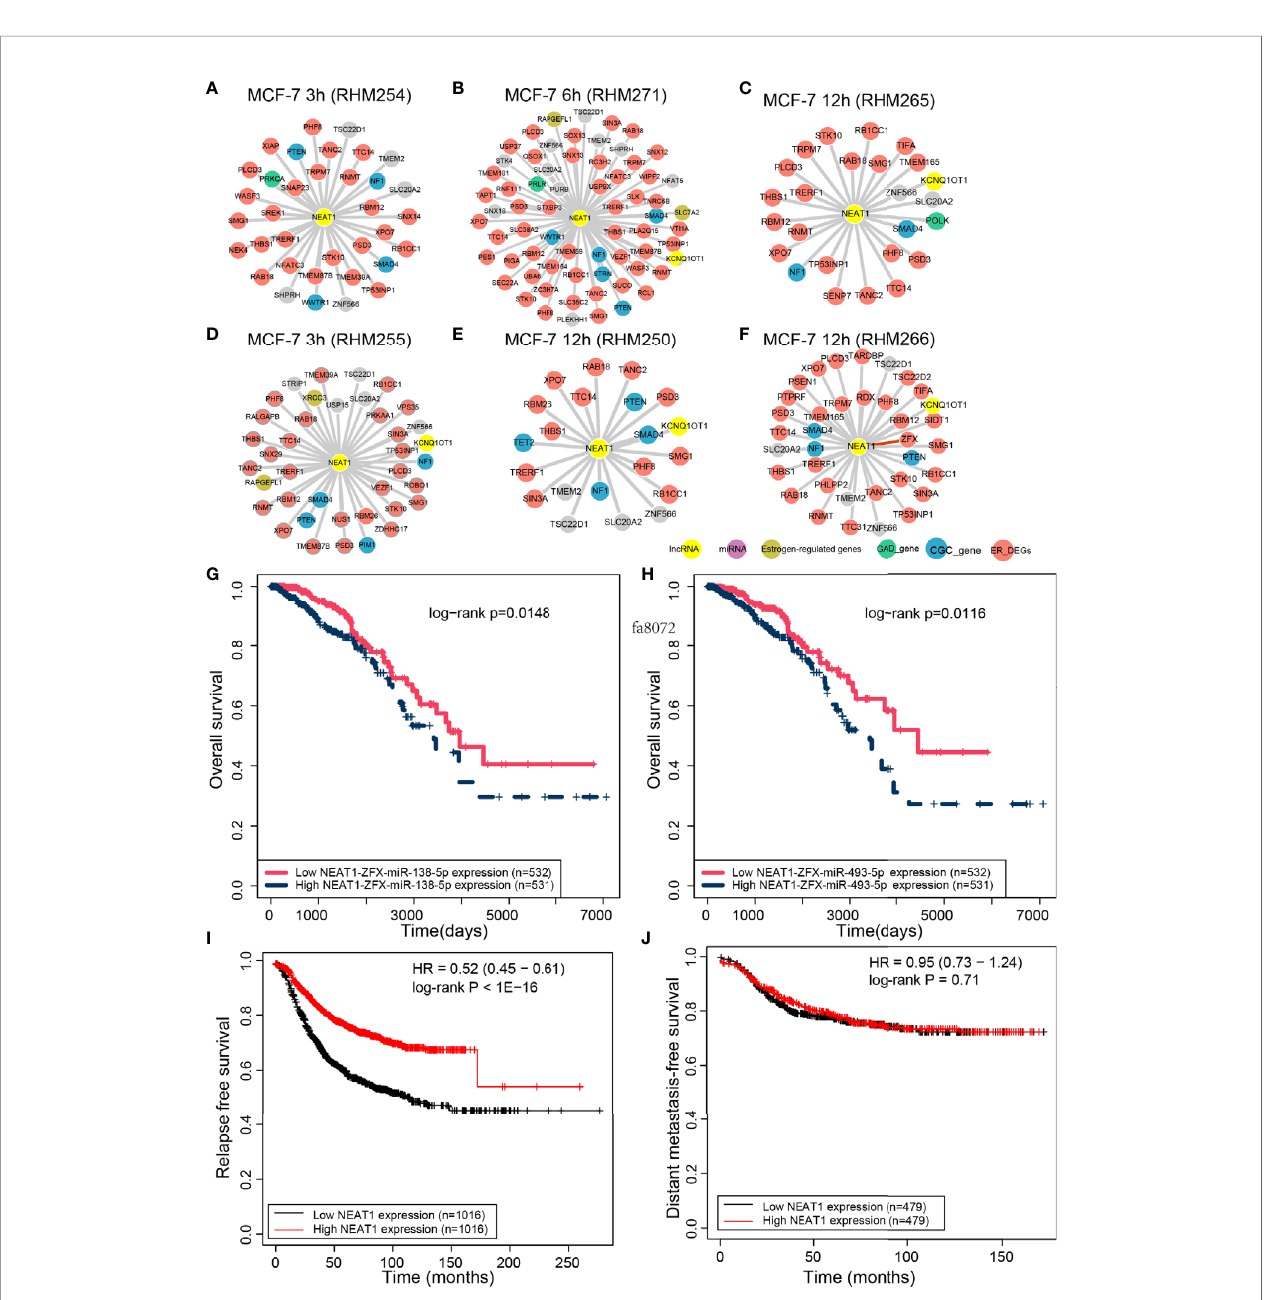
FIGURE 4 | NEAT1 interactors in the CCN. The interactions between NEAT1 and its ceRNAs in the (A) MCF-7 3 h (RHM254), (B) MCF-7 6 h (RHM271), (C) MCF-7 12 h (RHM265), (D) MCF-7 3 h (RHM255), (E) MCF-7 12 h (RHM250), and (F) MCF-7 12 h (RHM266) cells. The survival analysis of NEAT1 and its ceRNA ZFX binding to (G) miR-138-5p and (H) miR-493-5p. The relapse-free (I) and metastasis-free survival analysis (J) performed by Kaplan – Meier Plotter for